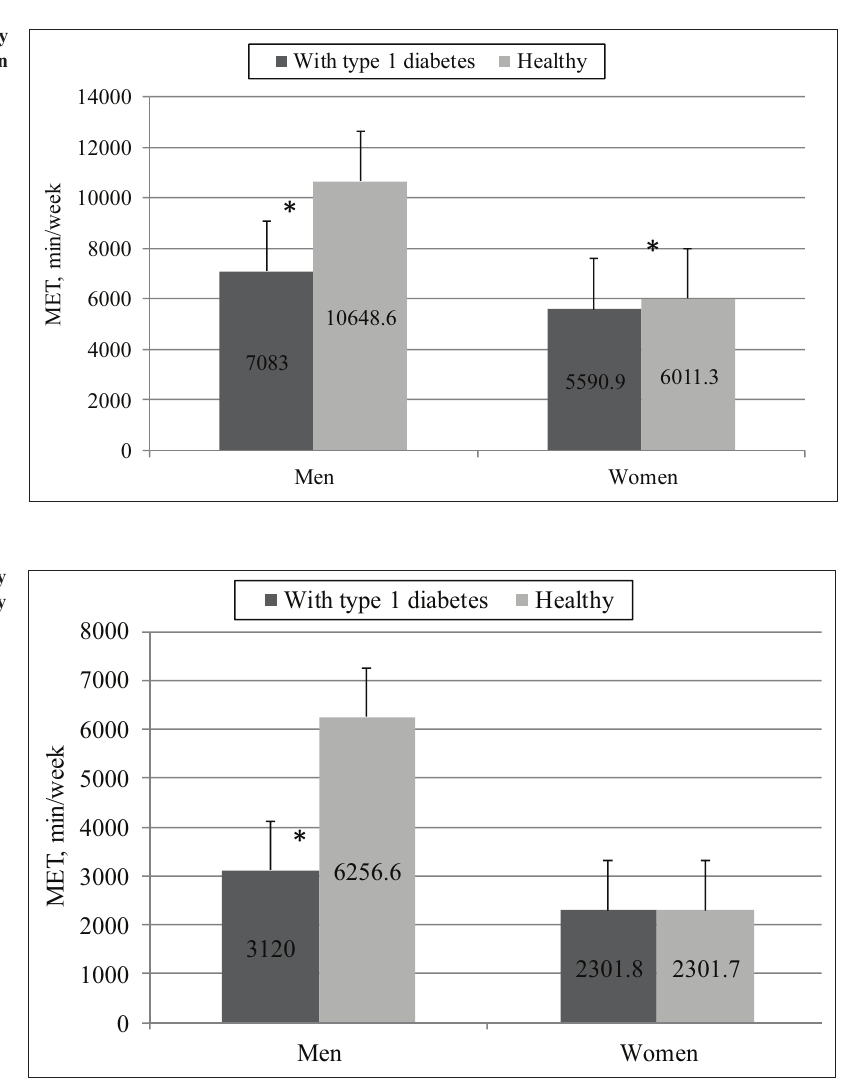
Figure 4. High physical activity assessed in MET values in the healthy and diabetes groups